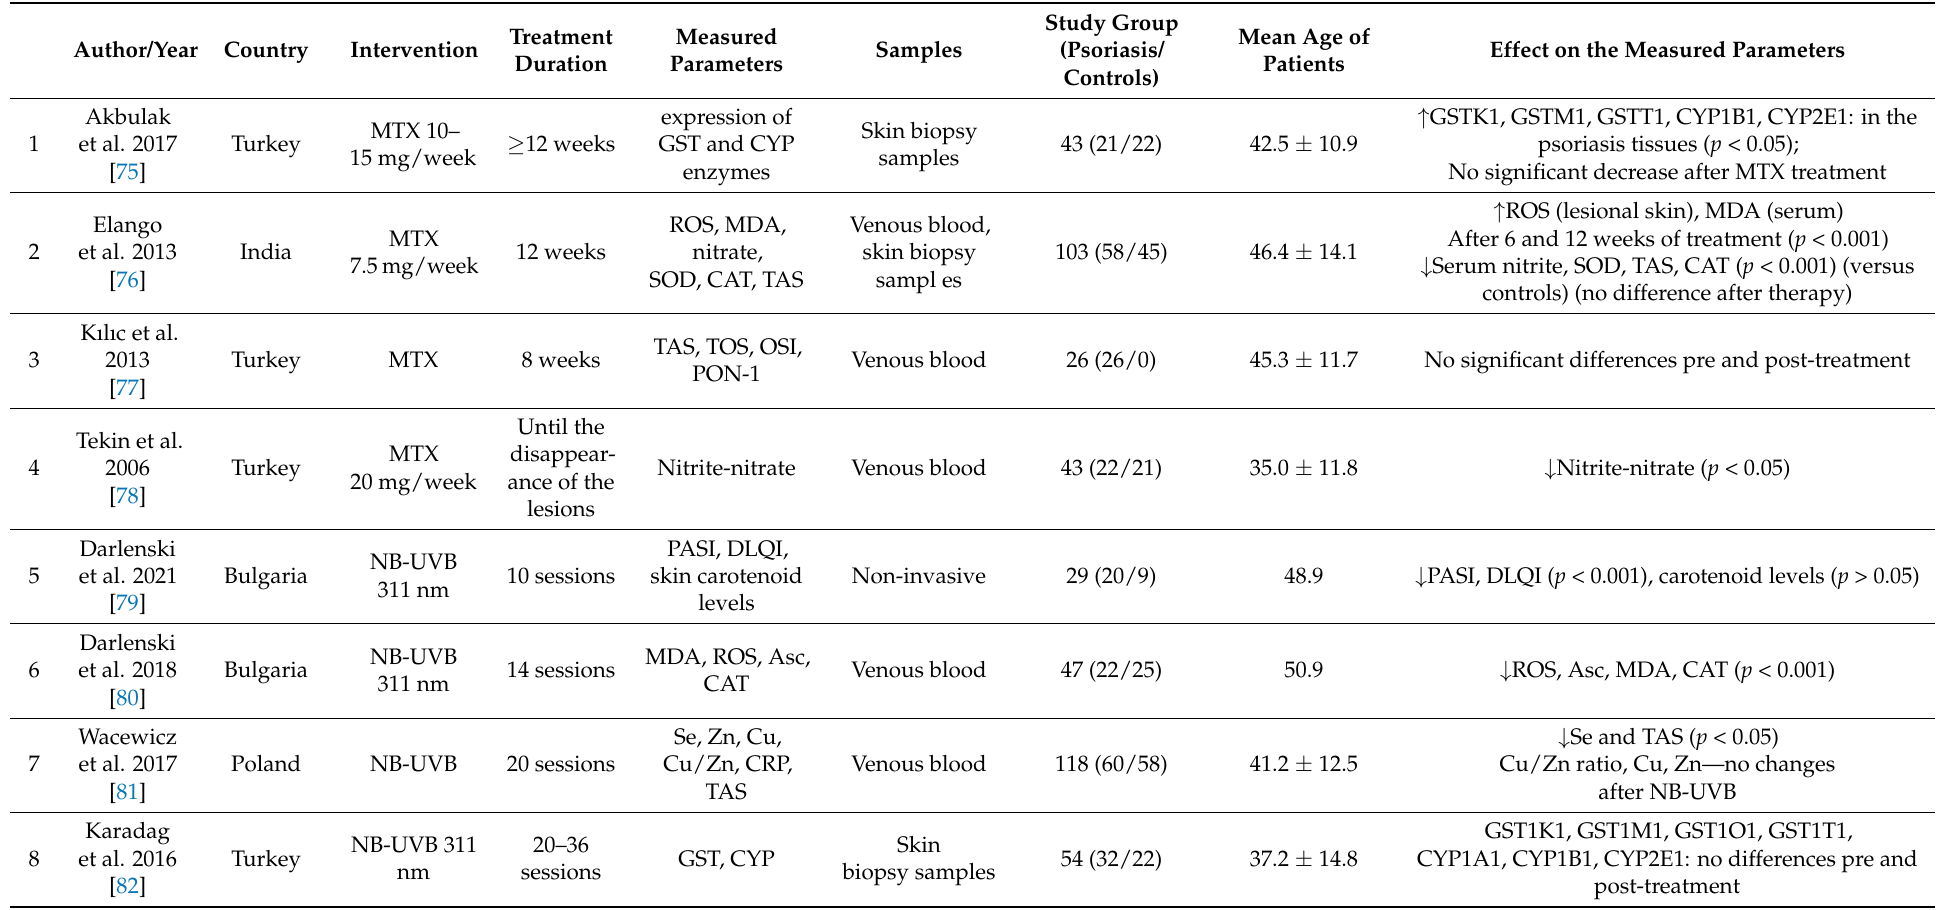
Table 3. The effect of anti-psoriasis therapy on oxidative stress